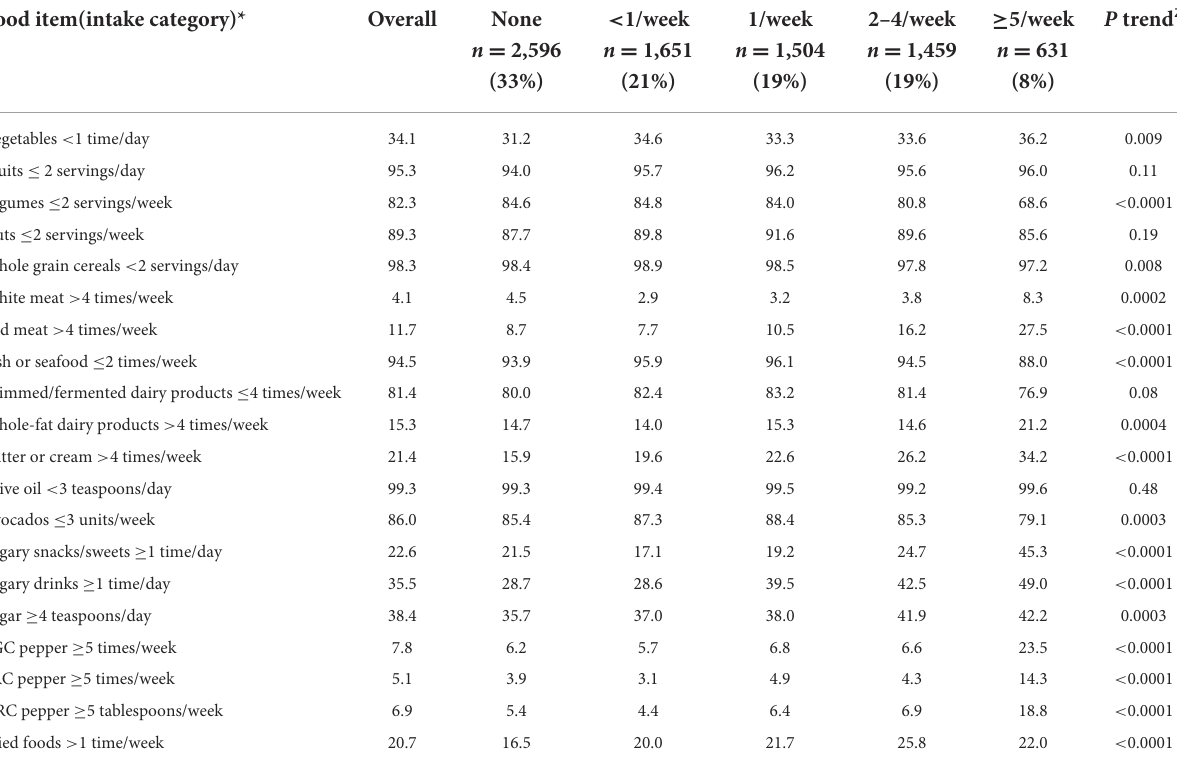
Frequency of processed meat